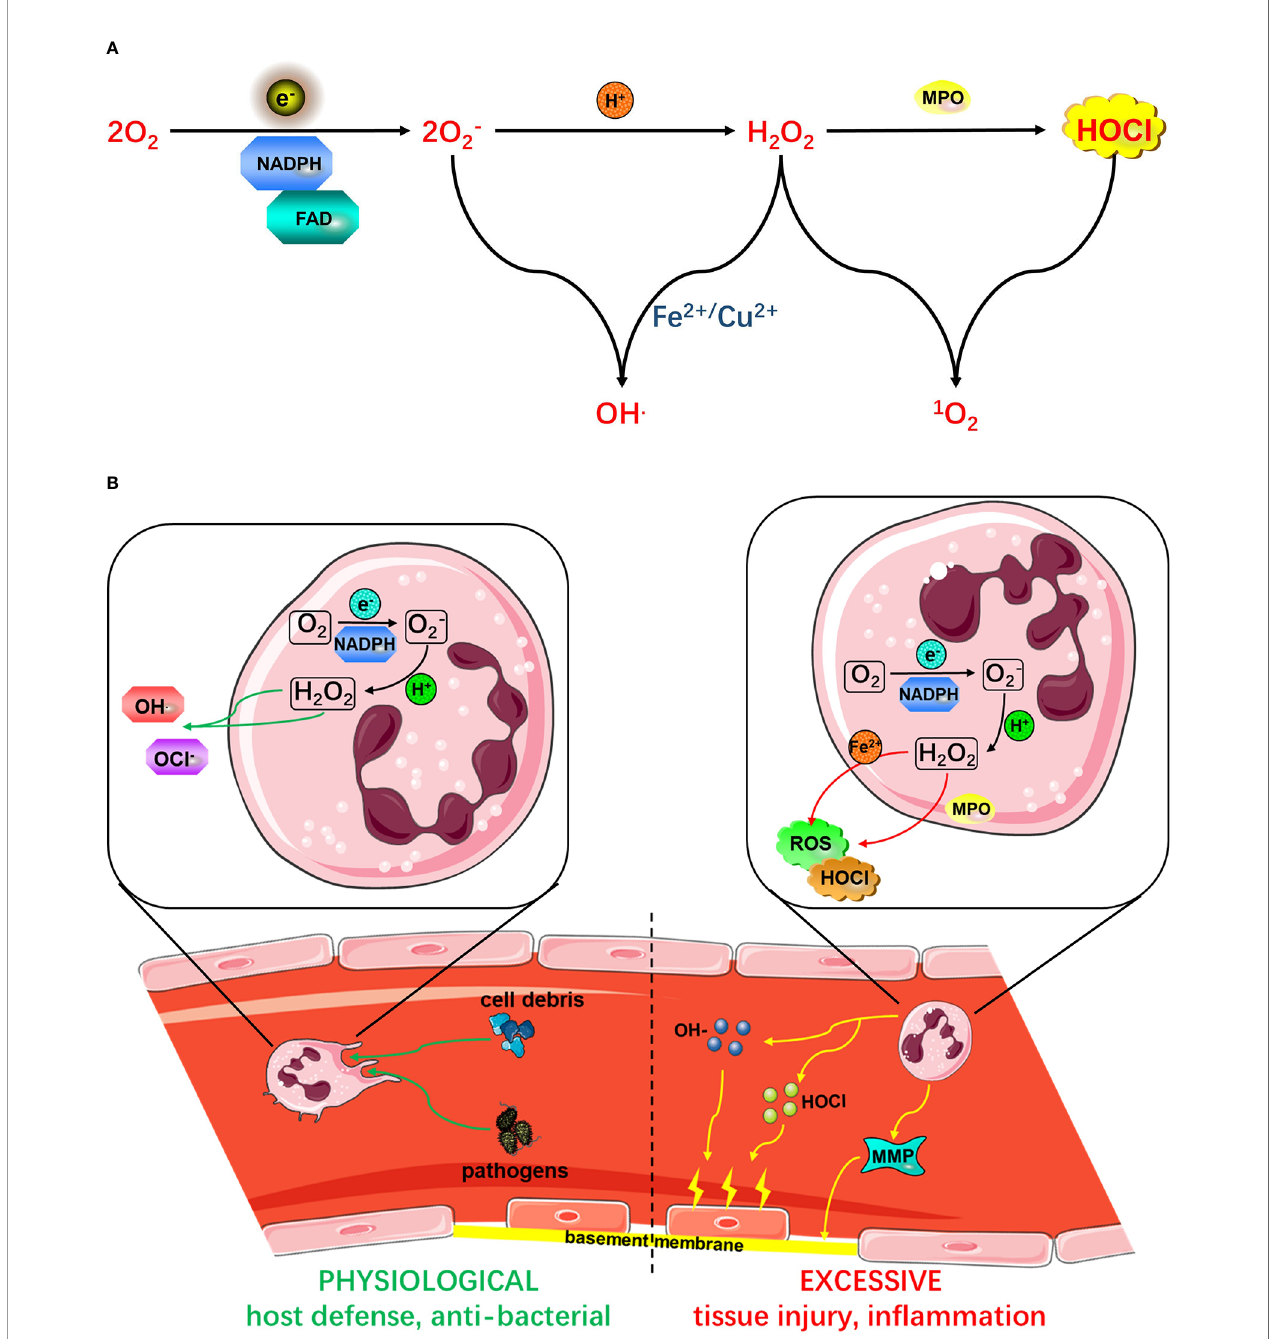
FIGURE 2 | (A) Active NADPH oxidase complexes promote ROS production. The activated NADPH oxidase complex uses fad to transfer electrons (e - ) to oxygen to form O − 2 . O − 2 produced by NADPH oxidase can react with protons to form H 2 O 2 , which in turn produces HOCl under the action of MPO. O − 2 can react with H 2 O 2 in the presence of Fe 2+ or Cu 2+ to form OH- or ROS. (B) The role of neutrophil activation in host defense and the in fl ammatory response. As shown on the left side, the initiation of proin fl ammatory cytokines or microbial molecules under physiological conditions is an immune-monitoring mechanism that ultimately enhances the antibacterial activity of neutrophils. However, as shown on the right side, excessive activation of neutrophil NADPH oxidase leads to excessive production of ROS, causing tissue damage and an excessive in fl ammatory response. Mediated by various proin fl ammatory mediators, receptor signals on the vascular endothelial surface are involved in neutrophil rolling, adhesion and endothelial barrier crossing. Phagocytosis of neutrophils leads to the activation of a series of processes, leading to the release of antimicrobial peptides, proteases, MPO and O − 2 from phagocytes. O − 2 , which is produced by the activation of NADPH oxidase, from